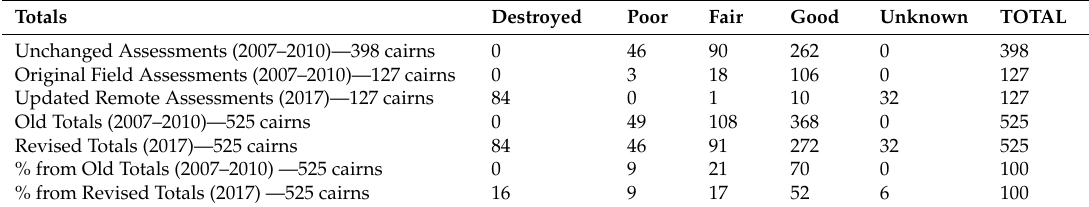
Table 10. Overall Condition State based on field survey and remote